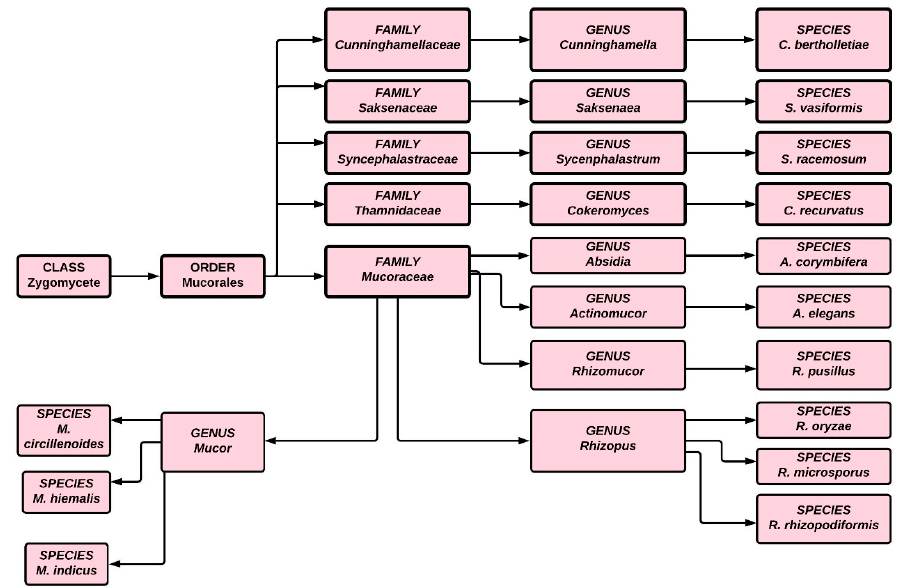
Figure 1. Classification of fungi in the zygomycete order.